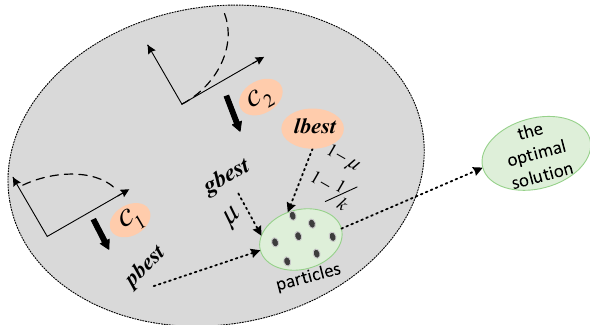
Figure 4. Schematic Optimization process of our improved particle swarm optimization (PSO).